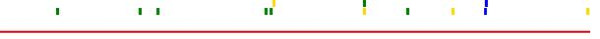
Schematics of zinc finger arrays binding to HPV type 18 E6 gene. This figure offers a diagrammatic illustration of loci of action of zinc finger arrays that specifically bind to 9 bp nucleotide sequences within the DNA context of the HPV type 18 transforming gene, E6. Hits (blue, green, and gold bars) represent targets along the gene (red bars). ZFA hits in the graphic are color-coded on the basis of spacer size (5 bp = Blue; 6 bp = Green; 7 bp = Gold).